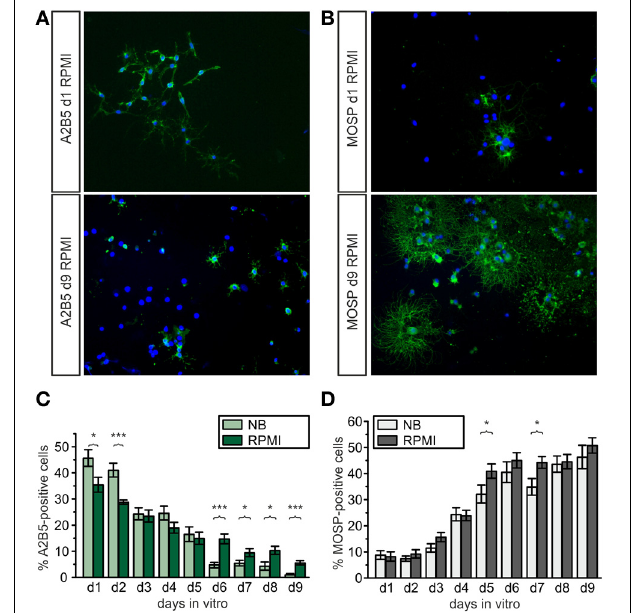
FIGURE 2 | Development of A2B5-positive progenitors and MOSP-positive oligodendrocytes in proliferation and differentiation media of different composition. (A,B) : Examples for A2B5- and MOSP-immunopositive cells cultured in RPMI vs. NB and stained at d1 and d9 after isolation. (A) Immunostained pictures of A2B5-positive cells, showing approximately 35% A2B5-positive cells at d1 (top) and 5% at d9 (bottom). (B) Immunostained pictures (right) of approximately 5% MOSP-positive cells at d1 (top) and almost 50% at d9 (bottom). Nuclei counterstained with DAPI. (C) Direct comparison of percentage of A2B5-positive cells cultured in Neurobasal and RPMI based media, (D) direct comparison of MOSP-positive cells cultured in either Neurobasal or RPMI based media ( ∗ p < 0 . 05, ∗∗∗ p < 0 . 005; error bars indicate ± s.e.m., paired Student’s t -test between pairs of